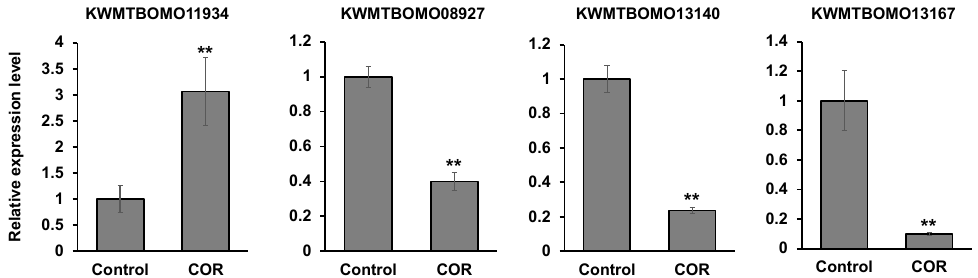
Figure 7. RT-qPCR analysis of each gene shown in Table 2. Total RNA was extracted Figure 3. ** p < 0.01.